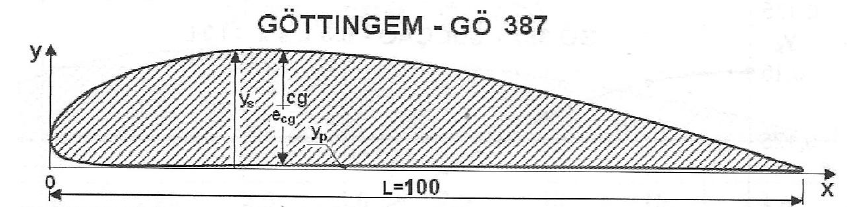
Figure 9. Hydrofoil GO 387 [46]. Table 3. Standard profile of the hydrofoil GO 387.